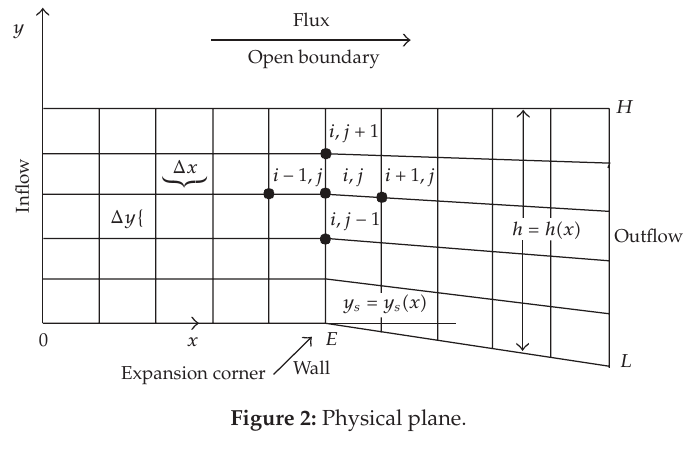
Figure 2: Physical plane.